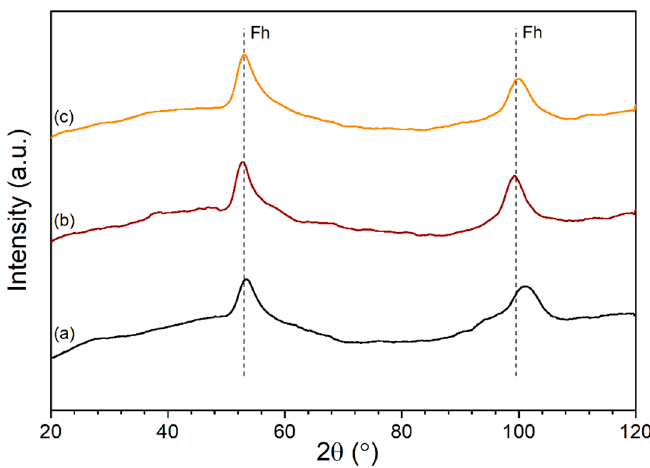
Figure 3. The XRD patterns of the powders obtained by reduction from Fe(NO 3 ) 3 with a concentration of CMC 1:0.002 ( a ), 1:0.0055 ( b ), and 1:0.0108 ( c ).